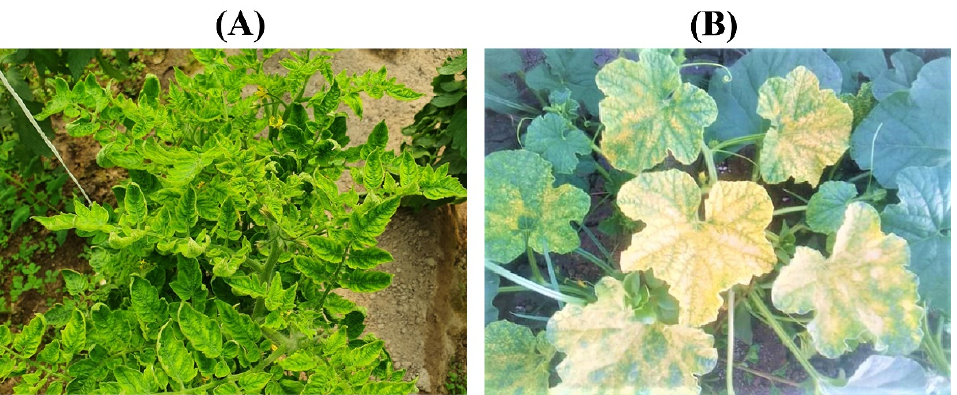
Figure 1. Virus infection symptoms on plants from Al-Ahsa region, Saudi Arabia; ( A ) symptomatic tomato plants showing leaf curling and yellowing; and ( B ) muskmelon plants showing leaf yellowing and mosaic symptoms.